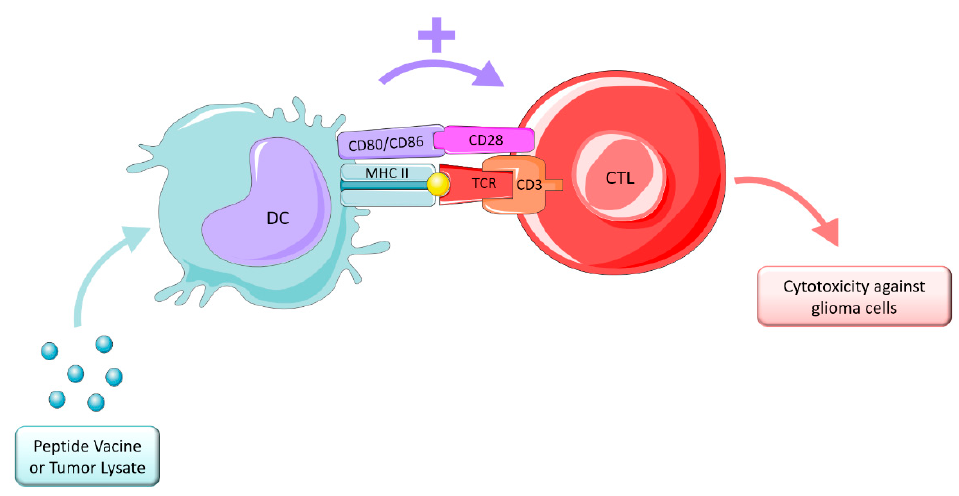
Figure 6. Vaccine therapy. Figure drawn with smart.servier.com.